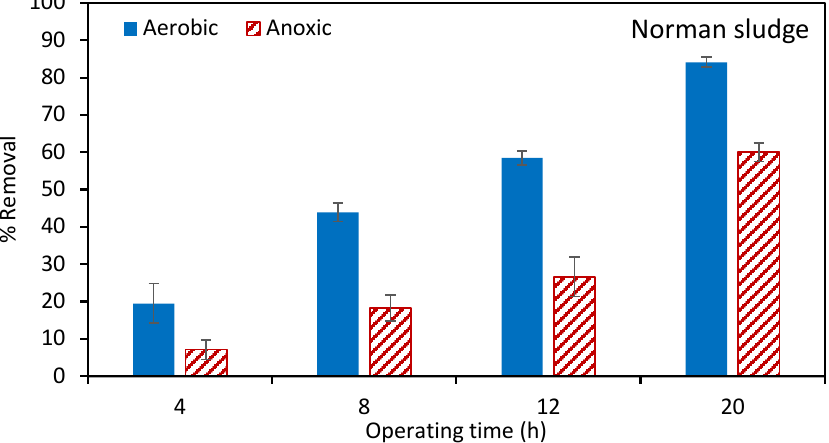
Figure 6. Parentage of atrazine removal using Norman sludge. The initial atrazine concentration was 1 ppm. The total suspended solids (TSS) for aerobic and anoxic tanks was 7244 and 5435 ± 600 mg/L, respectively.